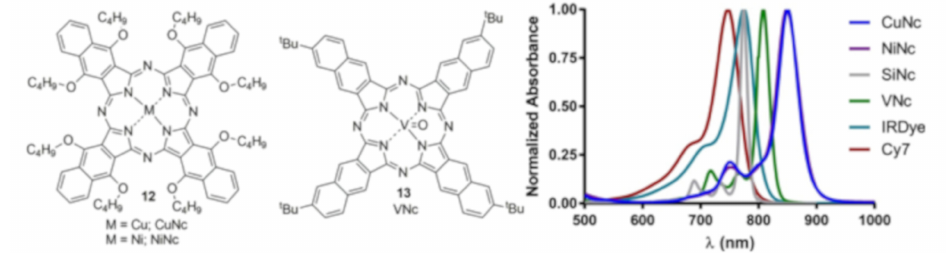
Figure 9. Chemical structure of naphthalocyanines ( 12 , 13 ) and their absorption spectral overlay along with other NIR-dyes (right). Reprinted with permission from Reference [95]. Copyright (2018):